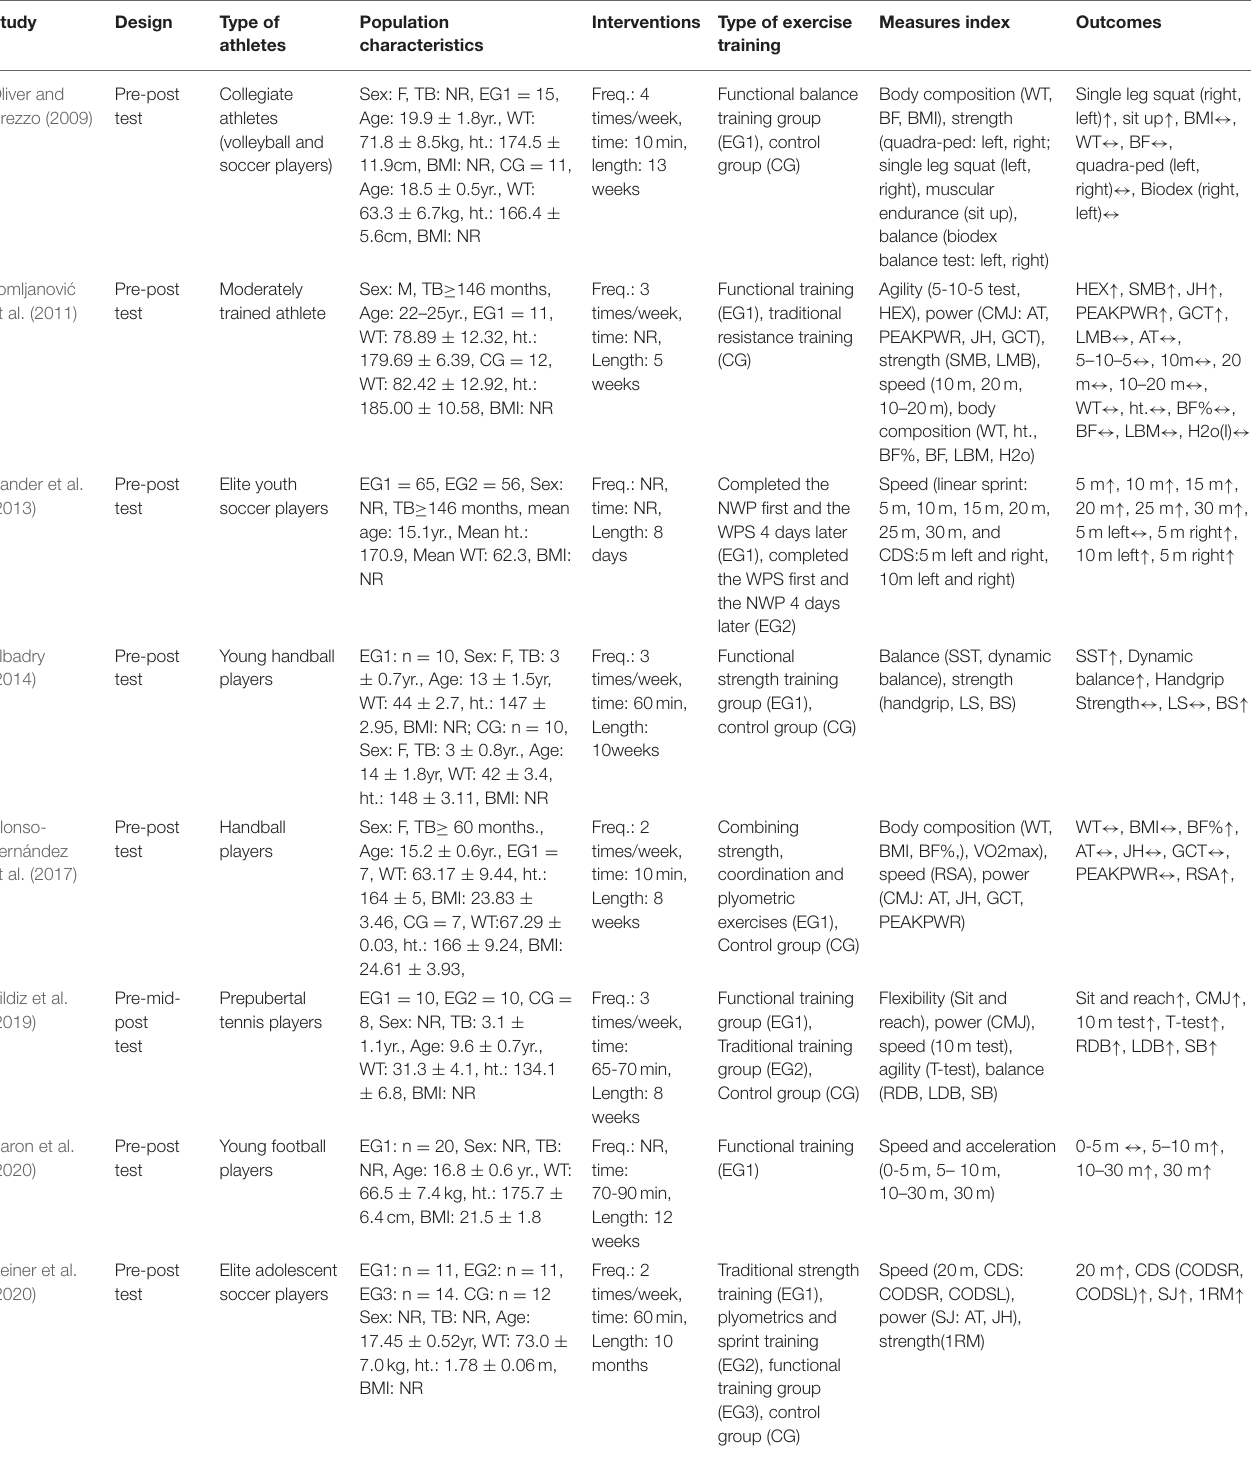
TABLE 2 | Characteristics of the studies examined in the present